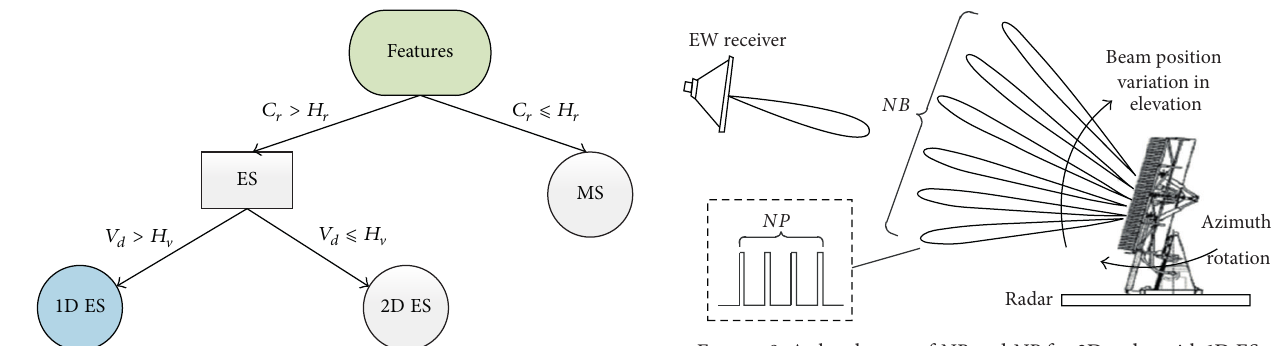
Figure 9: A sketch map of NB and NP for 3D radar with 1D